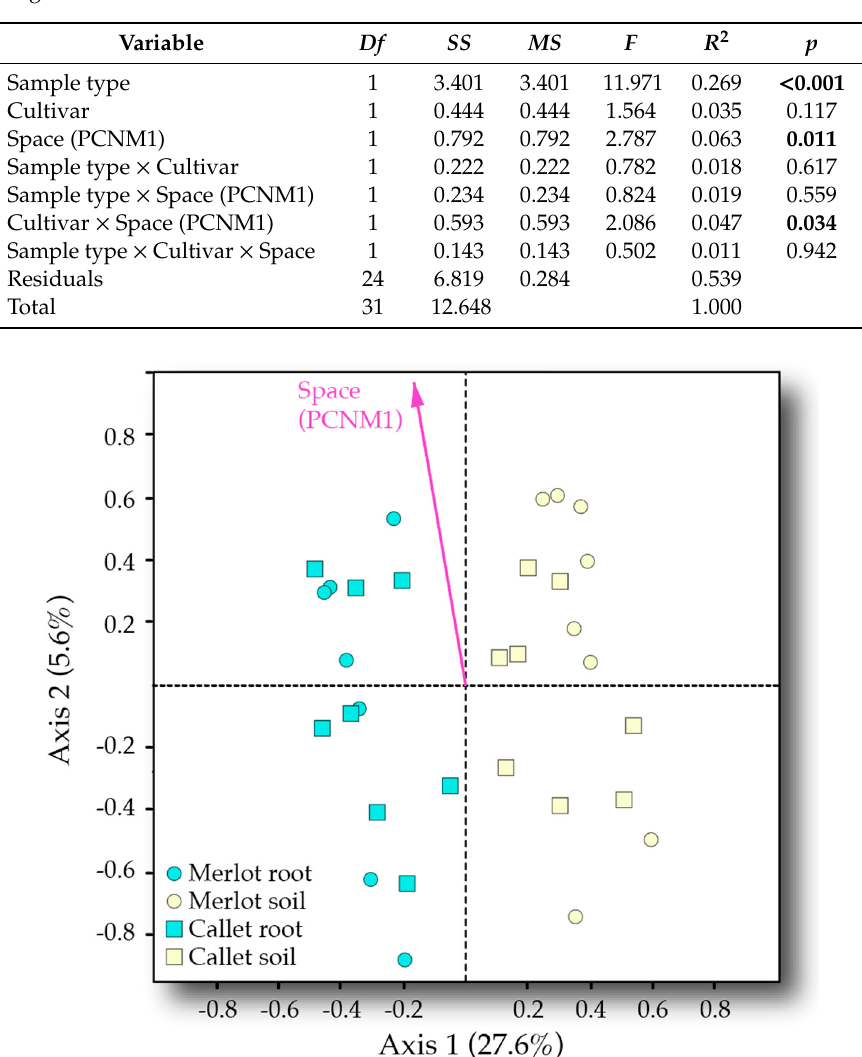
Figure 3. RDA ordination of AM fungal communities constrained by space (PCNM first axis), sample type (root or soil), and cultivar.